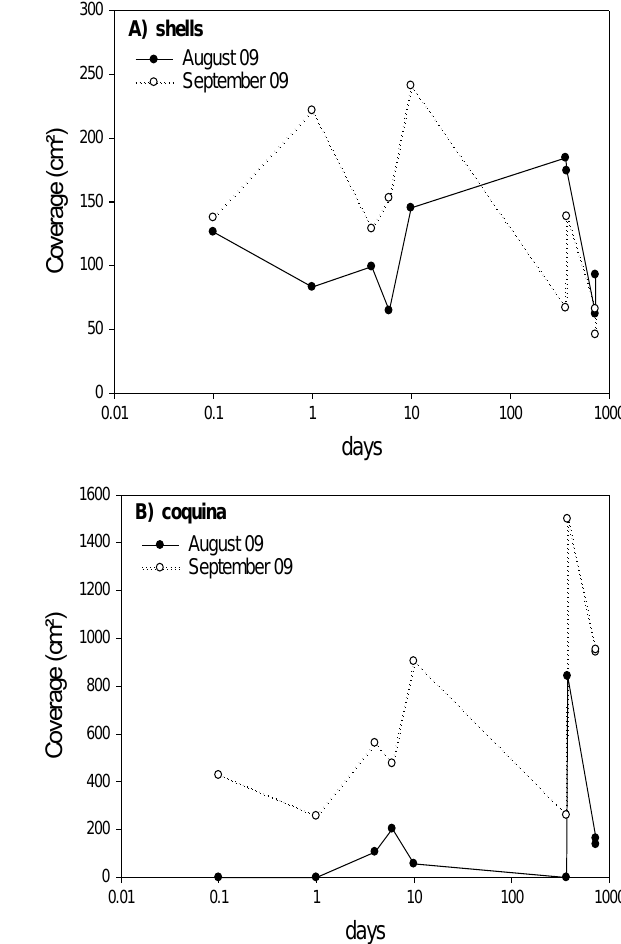
Figure 6: Coverage of shells after anoxia of the August and September 2009 plot (above) and of 883 coquina (below). Note different scales on y-axis. Start of experiment defined as 0.1 and initial 884 Fig. 6. Coverage of shells after anoxia of the August and September values measured inside closed chamber (original coverage). 885 2009 plot (above) and of coquina (below). Note different scales on y 886 axis. Start of experiment defined as 0.1 and initial values measured inside closed chamber (original